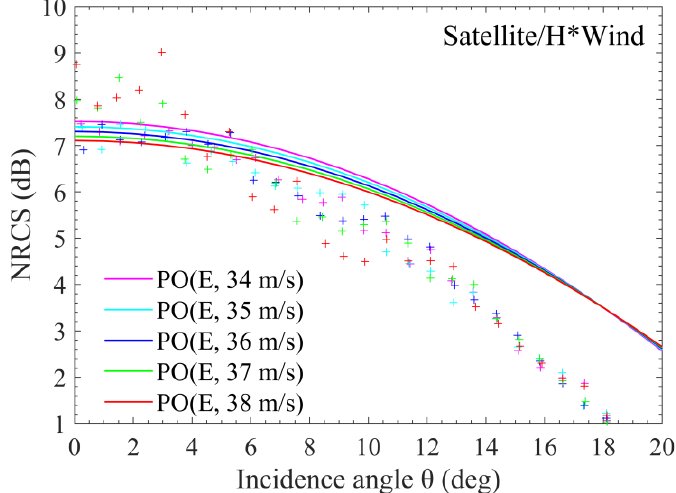
Figure 6. Comparison of the PO model computations using the E spectrum (solid lines) with the bin-averaged NRCS measurements calculated with the satellite/H*Wind data (pluses) at wind speeds of 34–38 m/s in 1 m/s intervals. Color sequence for the increasing wind speed is magenta, cyan, blue, green, and red.